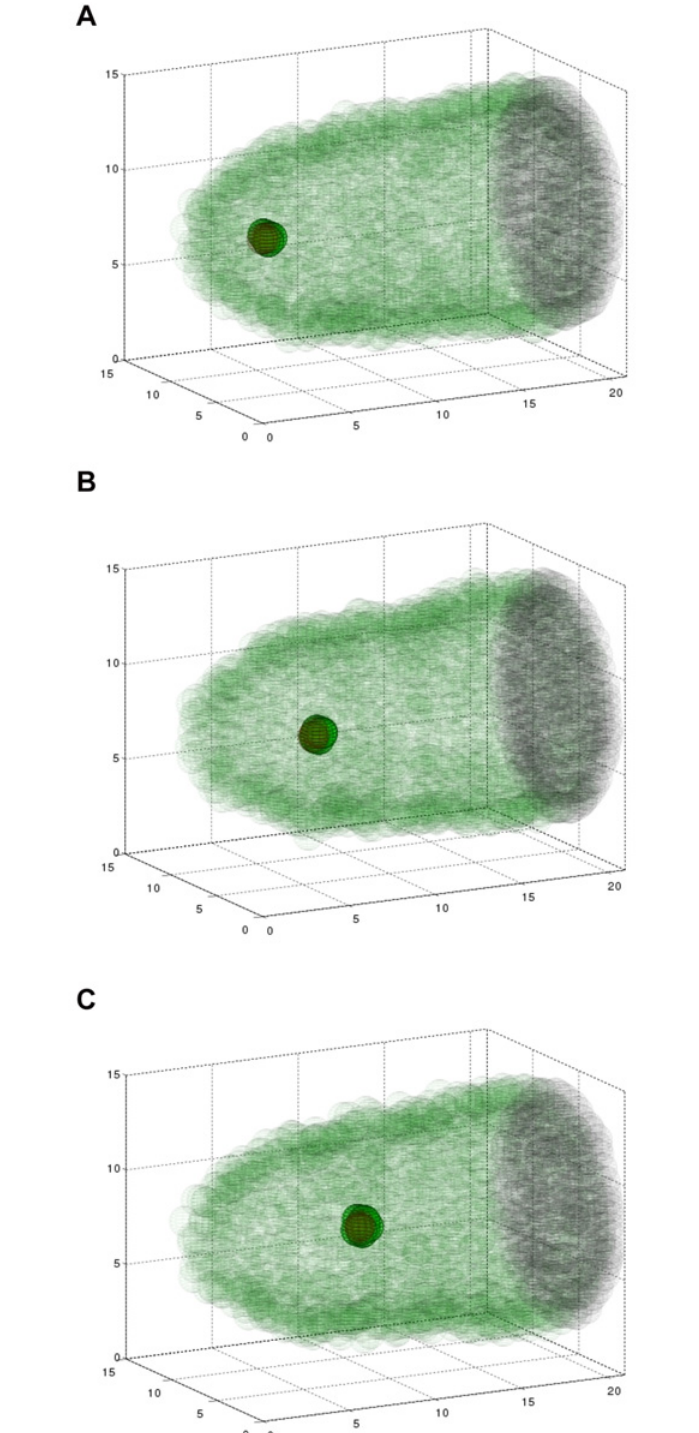
Fig 5. Simulations with four, six, and eight border cells at the same time point ( t = 1.8 hours) during migration. The cluster with four border cells (A) has moved significantly less distance than the cluster with six (B) or eight (C) border